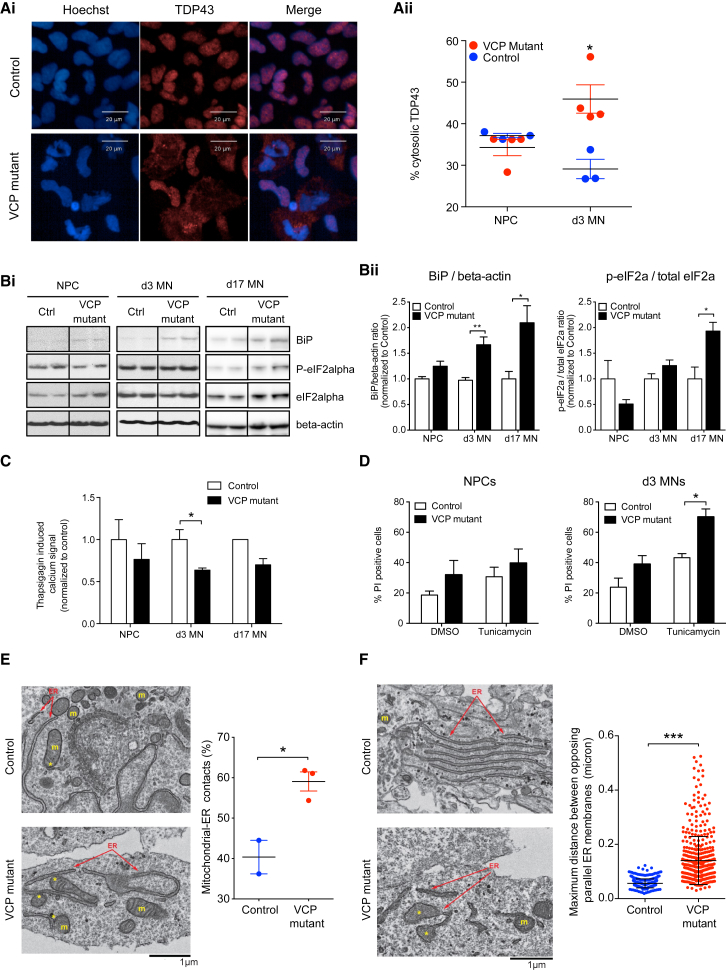
TDP-43 Mislocalization and Endoplasmic Reticulum Stress Are Early Molecular Events in VCP-Mutant Motor Neurons(A) (Ai) Immunofluorescence of control and VCP-mutant NPCs and d3 MN (blue, Hoechst; red, TDP-43). (Aii) Quantification of percentage of nuclear or cytosolic TDP-43 positive area, normalized to total TDP-43 positive area in d3 MNs (n = 3 control lines and 4 VCP-mutant lines. p < 0.05, unpaired t test; ≥ 2000 analyzed per line, each in technical triplicate).(B) (Bi and Bii) western blot images and quantification of BiP, phospho-eIF2alpha, total eIF2alpha, and β-actin levels in control and VCP-mutant NPCs, d3 MNs and d17 MNs (n = 3 control and 3 mutant clones, from at least three independent cultures per line each in technical triplicate, ∗p < 0.05, ∗∗p < 0.01, unpaired t test).(C) Histogram showing thapsigargin induced calcium signal measured in calcium free media (n = 3 control and 3 mutant clones, ∗p < 0.05, unpaired t test).(D) Histogram showing percentage of PI positive cells in control and VCP-mutant NPCs and d3 MNs with or without 48 hr treatment with ER stressor tunicamycin, n = 2 control lines and 3 mutant lines, p < 0.05, unpaired t test, > 50,000 cells per condition. Error bars represent mean ± SEM.(E) Representative EM images and quantification of mitochondria-ER contacts in control and VCP-mutant d17 MNs (n = 2 control lines and 3 mutant lines; n = 762 for control mitochondria and n = 1708 for VCP-mutant mitochondria; p < 0.05, unpaired t test,). Yellow asterisks show mitochondrial in contact with the ER (arrows). ER, endoplasmic reticulum; m, mitochondria.(F) Representative EM images and quantification of maximum distance between opposing parallel ER membranes (mean± SD 0.056 ± 0.0009 in control versus 0.140 ± 0.0041 in VCP-mutant, n = 375 ER from control and 463 ER from VCP mutant; p < 0.0001, unpaired t test). Yellow asterisks indicate dilated ER (arrows). ER, endoplasmic reticulum; m, mitochondria. NPC = neural precursor cells, MNs = motor neurons, d3 or d17 = after 3 or 17 days of terminal differentiation.